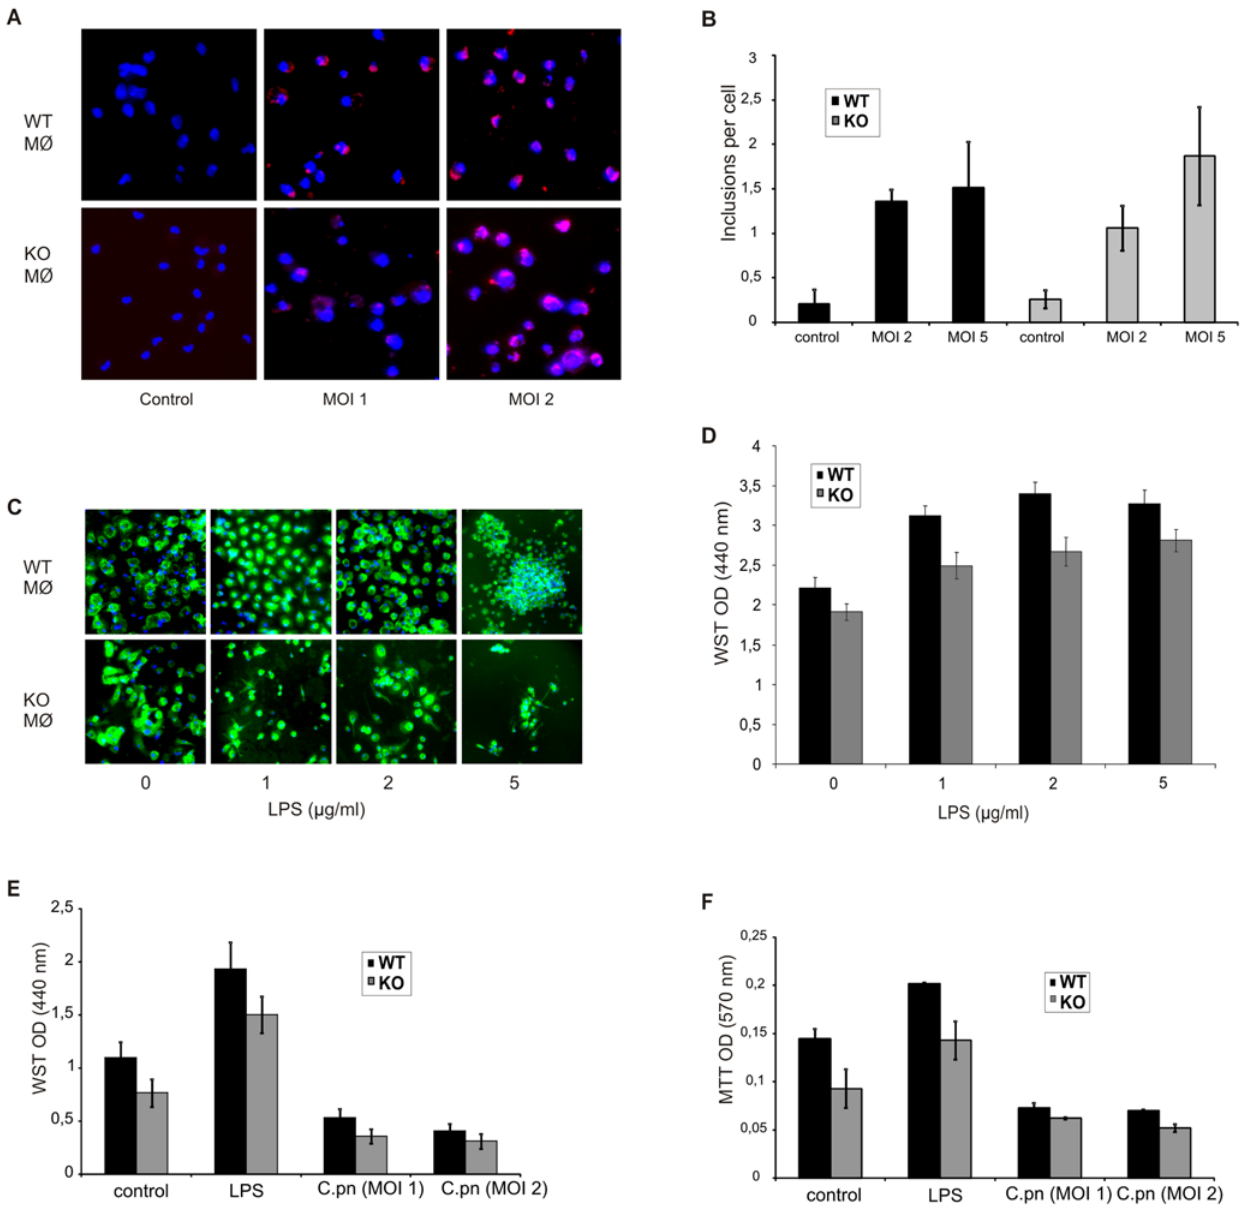
Figure 5. Impaired growth of cIAP-1 KO macrophages. A. Peritoneal macrophages from wildtype and ciap-1 KO mice were harvested and cultured in antibiotic free RPMI-1640 medium over night. Next day the macrophages were infected with C. pneumoniae at different MOI. 72 h post infection, the macrophages were fixed with chilled absolute methanol and stained with anti C. pneumoniae antibody. Shown here is the representative micrographs of the macrophage infected. B. Quantification of inclusions in macrophages. 1 6 10 4 wildtype and cIAP-1 KO macrophages were cultured in 96 well plates in antibiotic free medium and infected with different doses of C. pneumoniae . The cells were fixed and stained with anti- C. pneumoniae antiserum. The inclusion in the macrophages were determined by automated microscopy as described in Materials and Methods. Data are represented as mean 6 SEM from three independent experiments. C. Quantification of Mac-1 + (CD11b + ) peritoneal macrophages. The macrophage from wildtype and cIAP-1 macrophage were treated with increasing doses of LPS and Mac-1 + peritoneal macrophage were compared among wildtype and KO mice. Shown here is the immune fluorescence picture of Mac-1 + macrophages (green) and DNA (blue) and analyzed by immunofluorescence microscopy. D. Mouse peritoneal macrophages from wildtype and cIAP-1 KO mice were stimulated ex vivo with different doses of LPS and their survival was measured 48 h later by WST assay. E. Toxicity of C. pneumoniae infection on macrophages. Metabolic activity of infected was determined by standard WST assays as described in Supporting Materials and Methods S1. Data are represented as mean of OD 6 SEM from three independent experiments. F. The survival of macrophages under infection experiments was measured by standard MTT assays as described in Supporting Materials and Methods S1. Data are represented as the mean OD 6 SEM from three independent